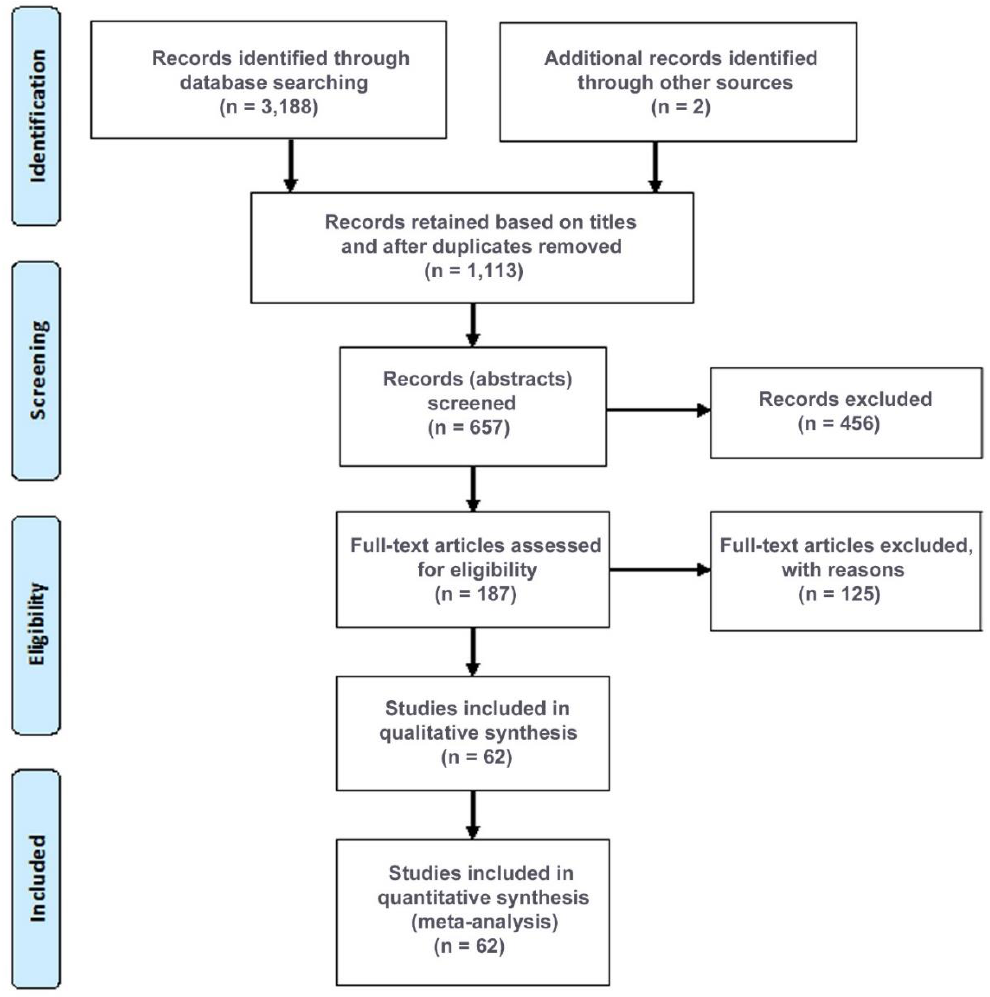
Figure 1. Flowchart illustrating the literature search, systematic review, and meta-analysis according to the PRISMA guidelines. PubMed, the NIH COVID-19 portal, and Google Scholar were searched systematically; other sources were found in references of articles and in news media. The literature was last updated on January 10, 2023. Given in decreasing frequency, the reasons for exclusion of full-text articles were as follows: no prevalence data; no data on omicron; long (not acute) COVID; children-only; review; and case report.